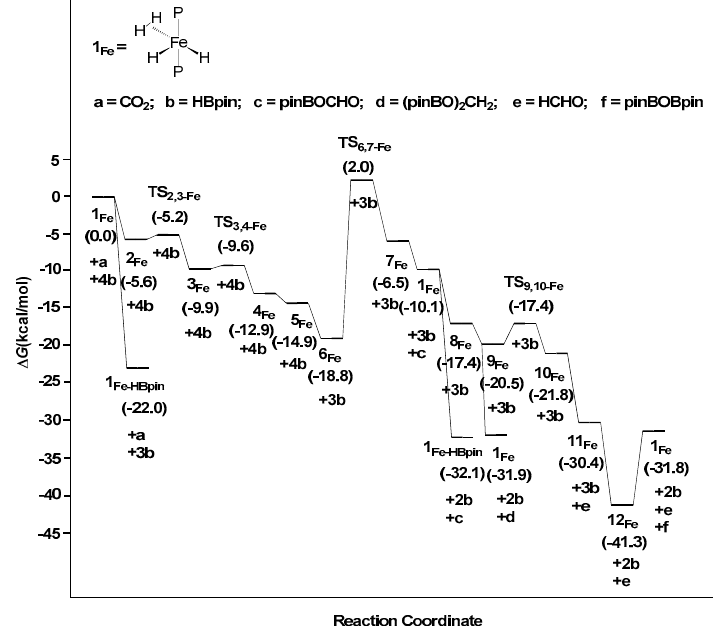
Figure 3. Free energies profile of the reduction of carbon dioxide to formaldehyde catalyzed by 1 Fe .